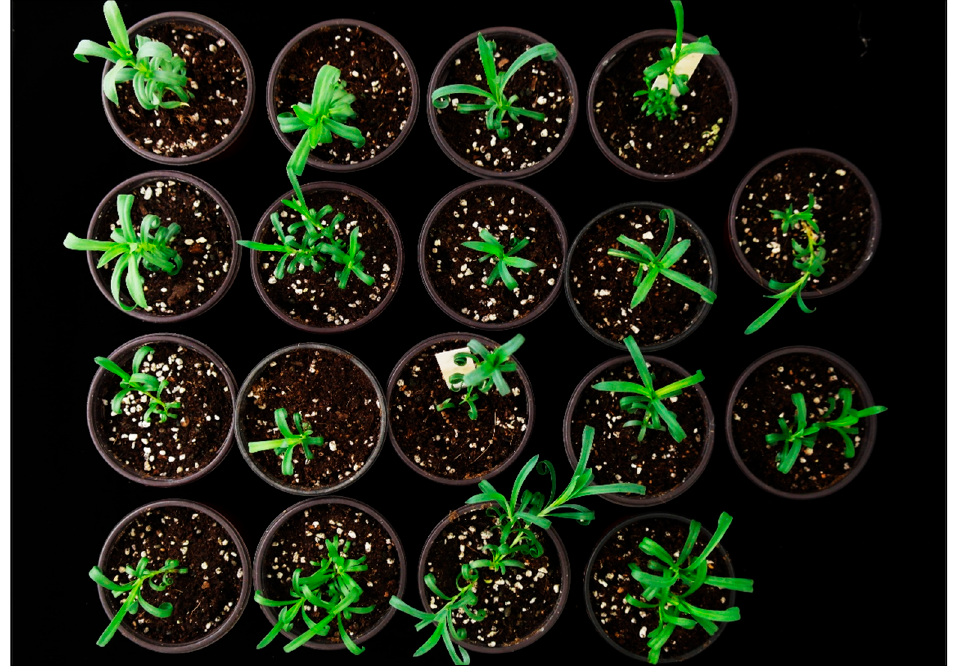
Figure 5. Vitrified-derived leaves in vitro regenerated, and normalized plants of the carnation cultivars then survived well under greenhouse conditions.